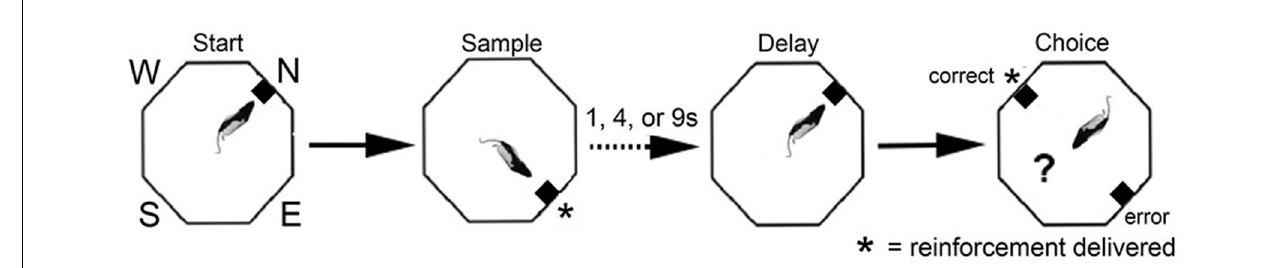
FIGURE 6 | Schematic drawing of dynamic DNMTP (dDNMTP) task. Training occurred in open octagonal chambers, equipped with levers on four walls, 90 ◦ apart, with a drinking spout above each lever to deliver reinforcement. Trials began with a randomly selected lever (N, E, S, or W) extending for the start response. The sample and correct choice levers were 90 ◦ to the left or right of the start lever, which also served as the delay lever (extending at the end of the memory delay to initiate the choice response). The length of the retention interval and the direction of the sample lever (L vs. R) were randomly selected for each trial. Reinforcement was given following the sample press and when the non-matching to sample lever was pressed during the choice phase. See text for